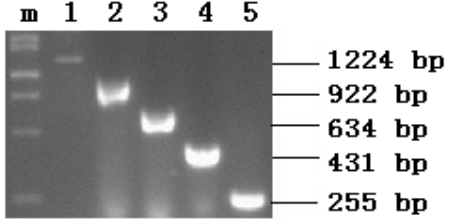
Figure 1. Identification of the PCR products by electrophoresis in 1% agarose gel. m : DNA marker; 1 , 2 , 3 , 4 , and 5 denote the PCR products.